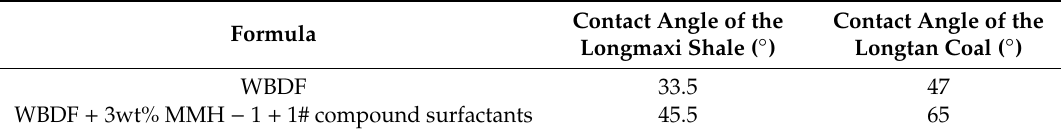
Table 7. E ff ect of optimized compound surfactants on contact angle ( ◦ ) of the Longmaxi shale and the Longtan